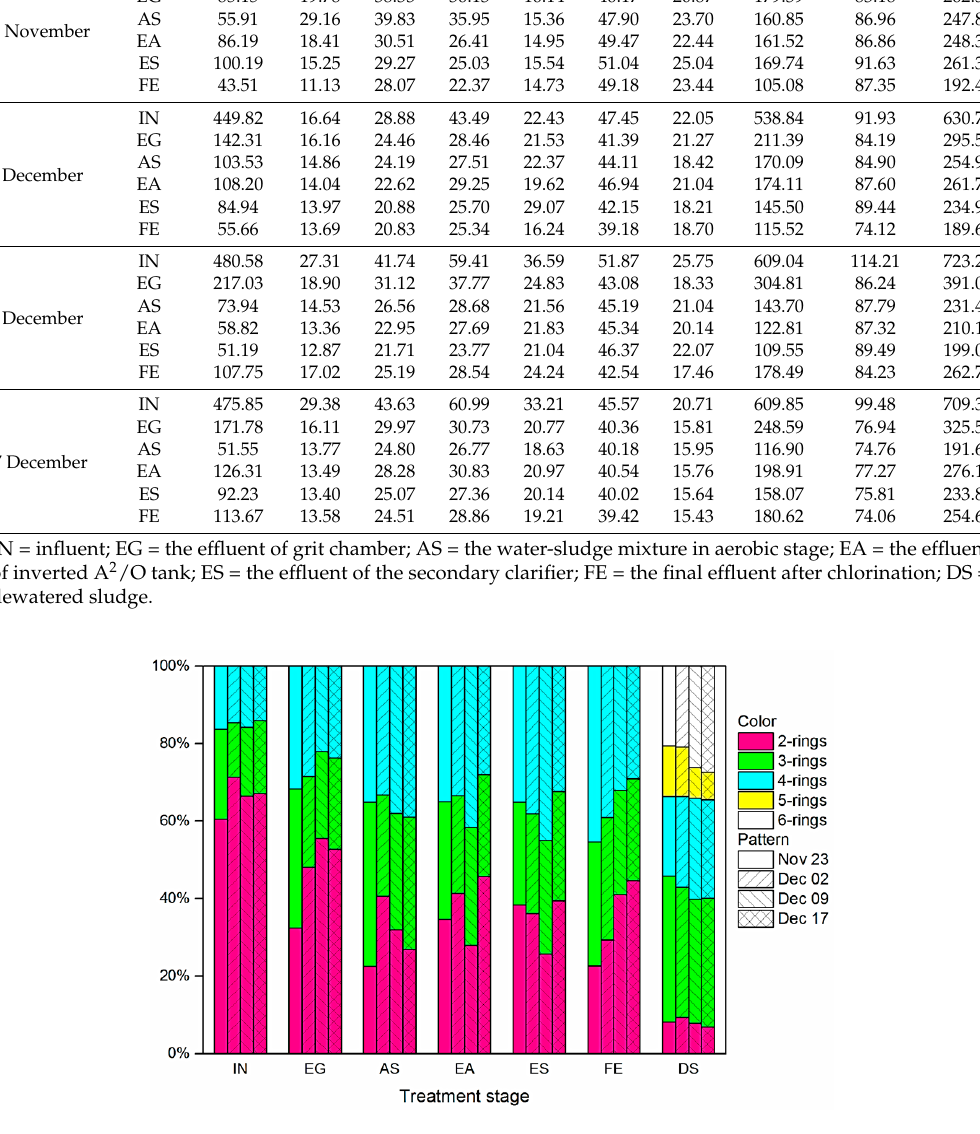
Table 1. Concentration of PAHs at various stages of sewage treatment (ng/L).